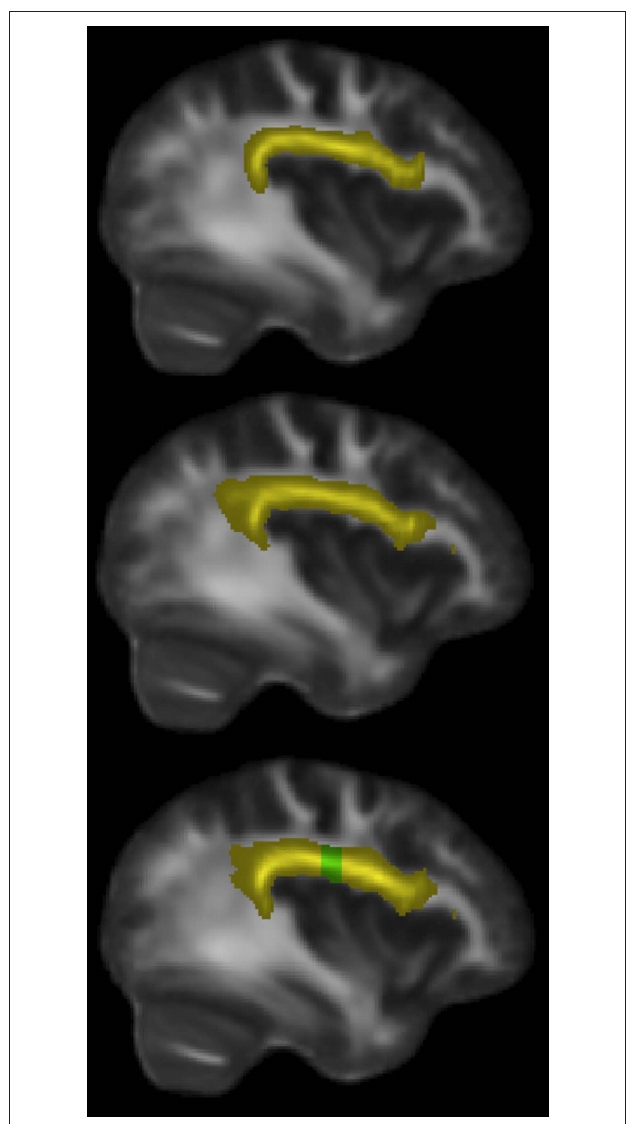
Figure 4 | Sagittal slice x = 38 mm, showing left dorsal AF in yellow: instrumental controls (top). Singers (middle). All musicians (bottom), with region showing significant FA differences at y = − 22 to − 13 mm, shown in green.